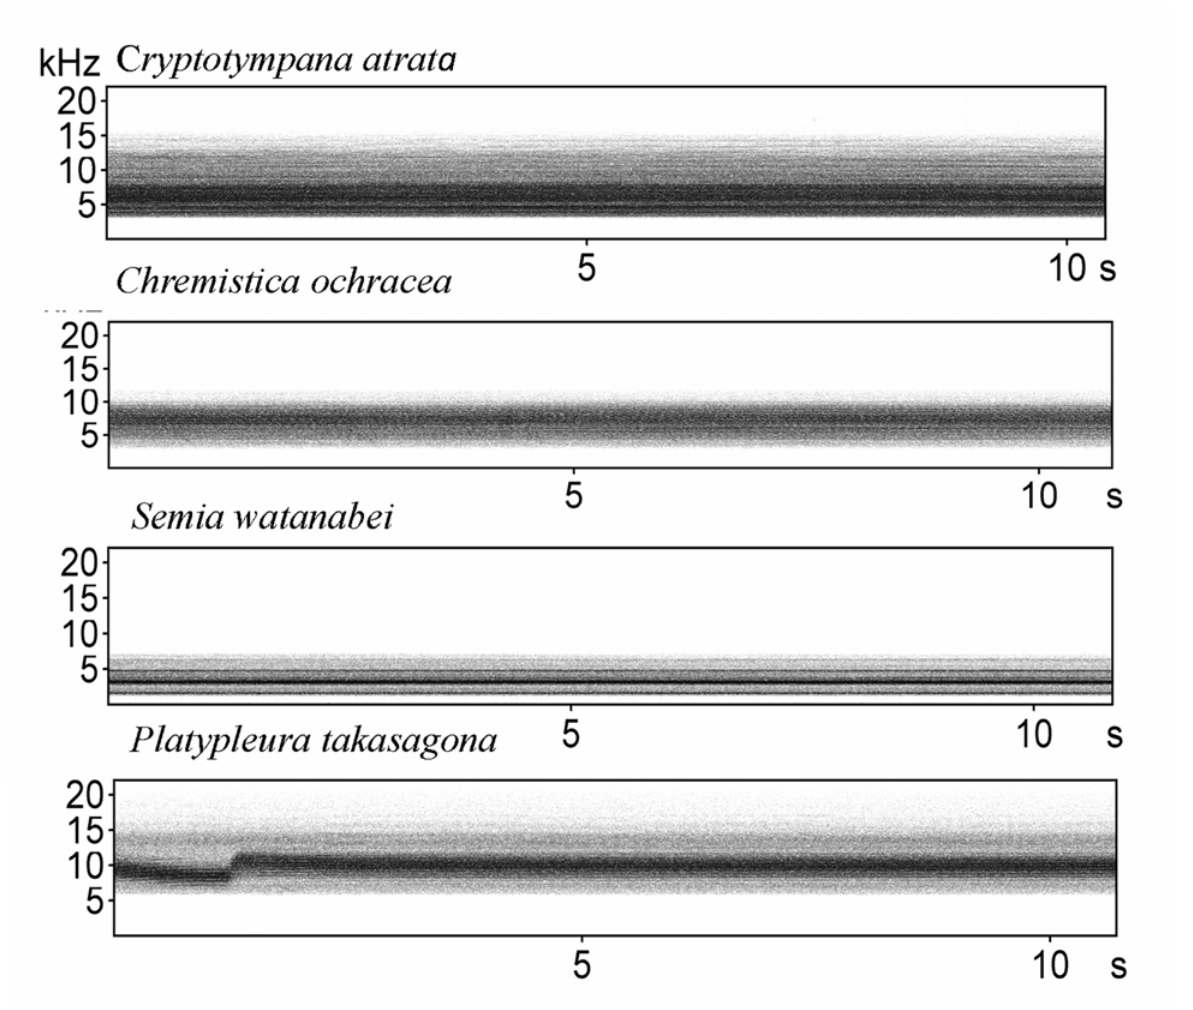
Figure 1. Spectrograms of cicada calling songs of tonal band